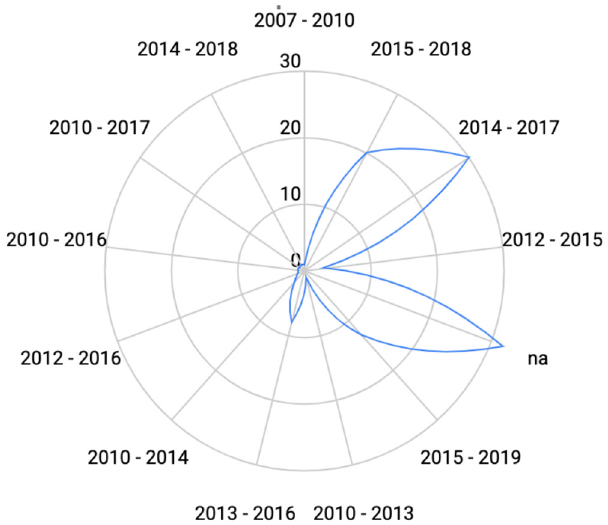
Fig. 3. Radar chart shows a large amount of old and missing data in the 2020 UN SDG report.